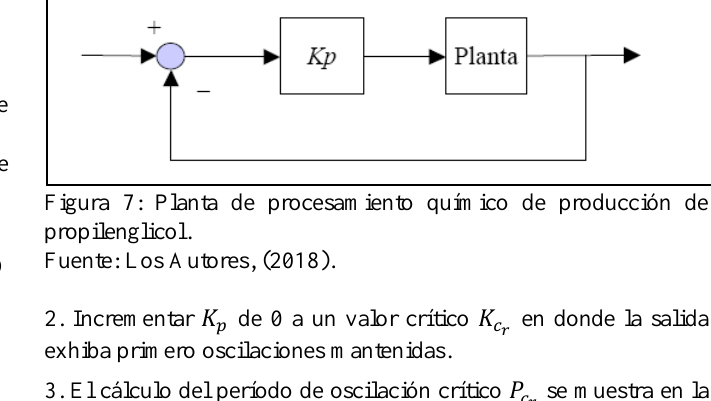
exhiba primero oscilaciones